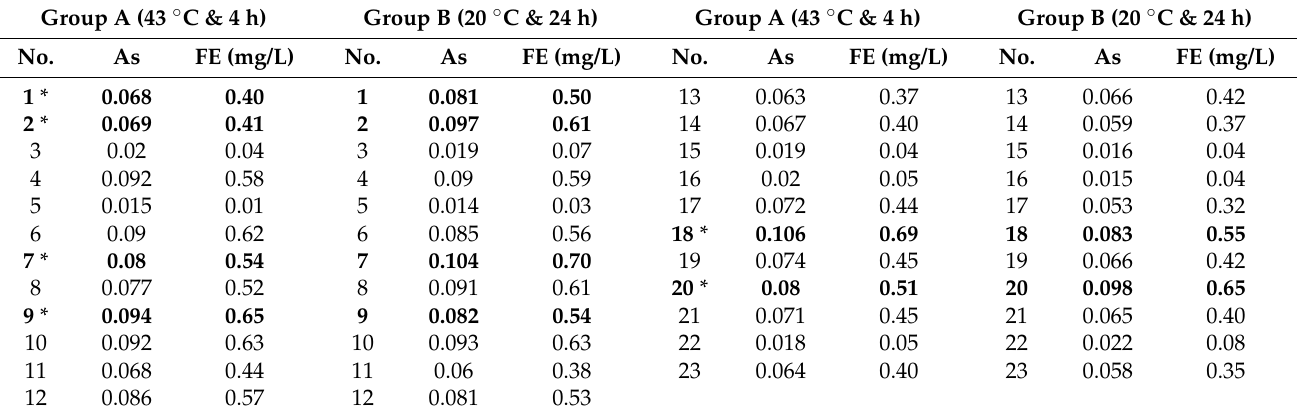
Table 5. Formaldehyde emissions data measured by the desiccator at 43 ◦ C for 4 h and 20 ◦ C for 24 h.